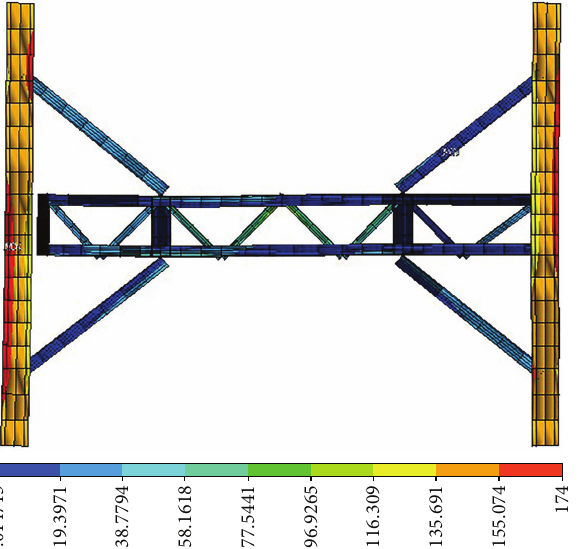
Figure 20: Stress when horizontal load is 105kN.